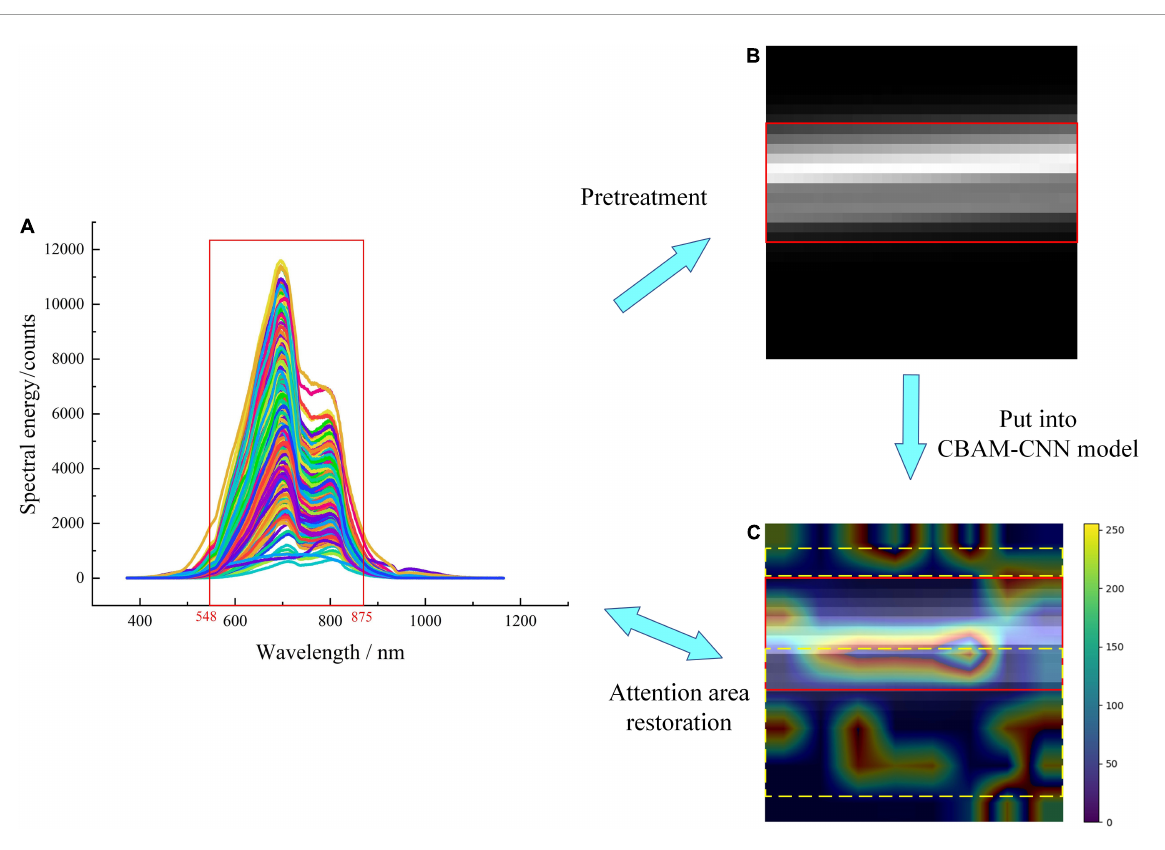
superimposed with the original image, which further shows the localization of some regions in the image by the network, and more intuitively explains the learning ability of the network